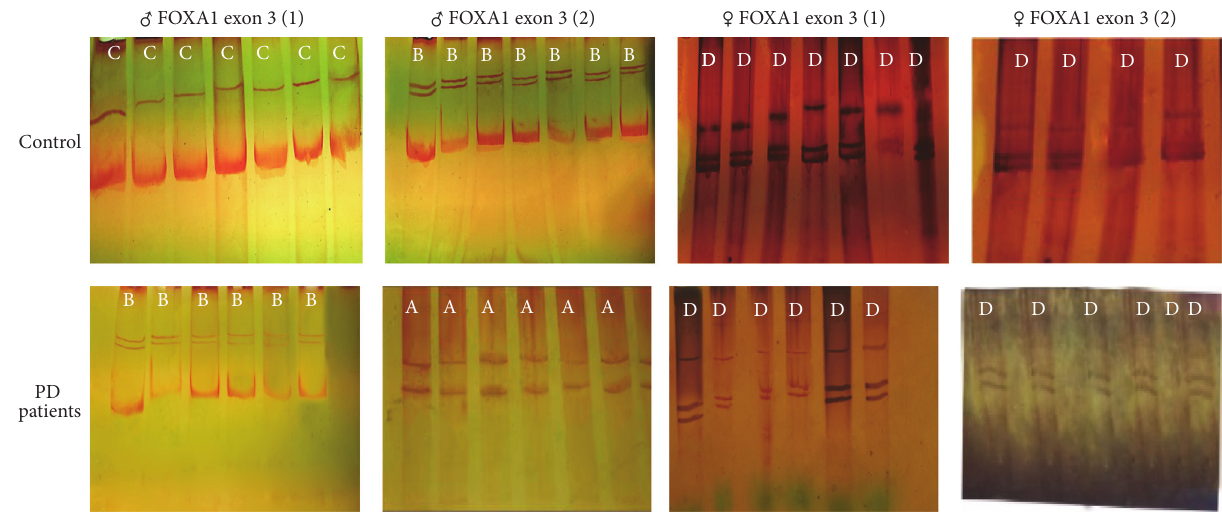
Figure 5: Representative SSCP analyses for exon 3 of the FOXA1 gene in male and female PD patients. The exon was divided into two reactions: 1 and 2. A, B, C, and D represents conformational patterns of the bands found. Table 5: Mean values ( ± SEM) of mRNA expression ( 2 −Δ ct ) with PCR-SSCP patterns of NURR1 and FOXA1 gene.